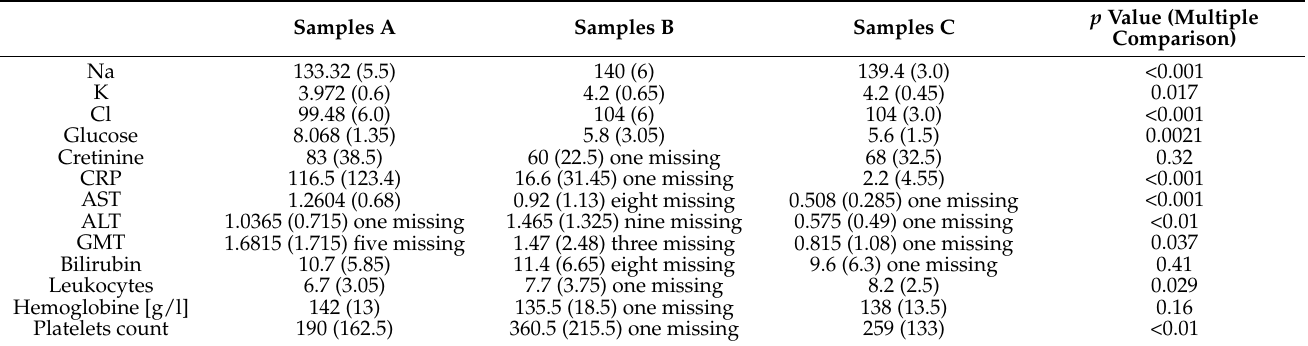
Table 4. Standard biochemical and hematological results of patients at the sampling times, me- dian